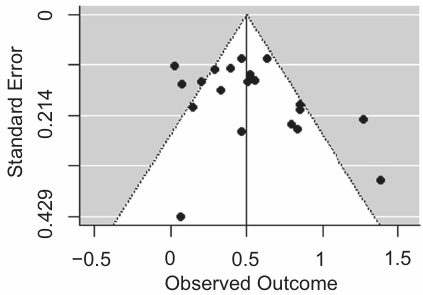
Figure 3. Funnel